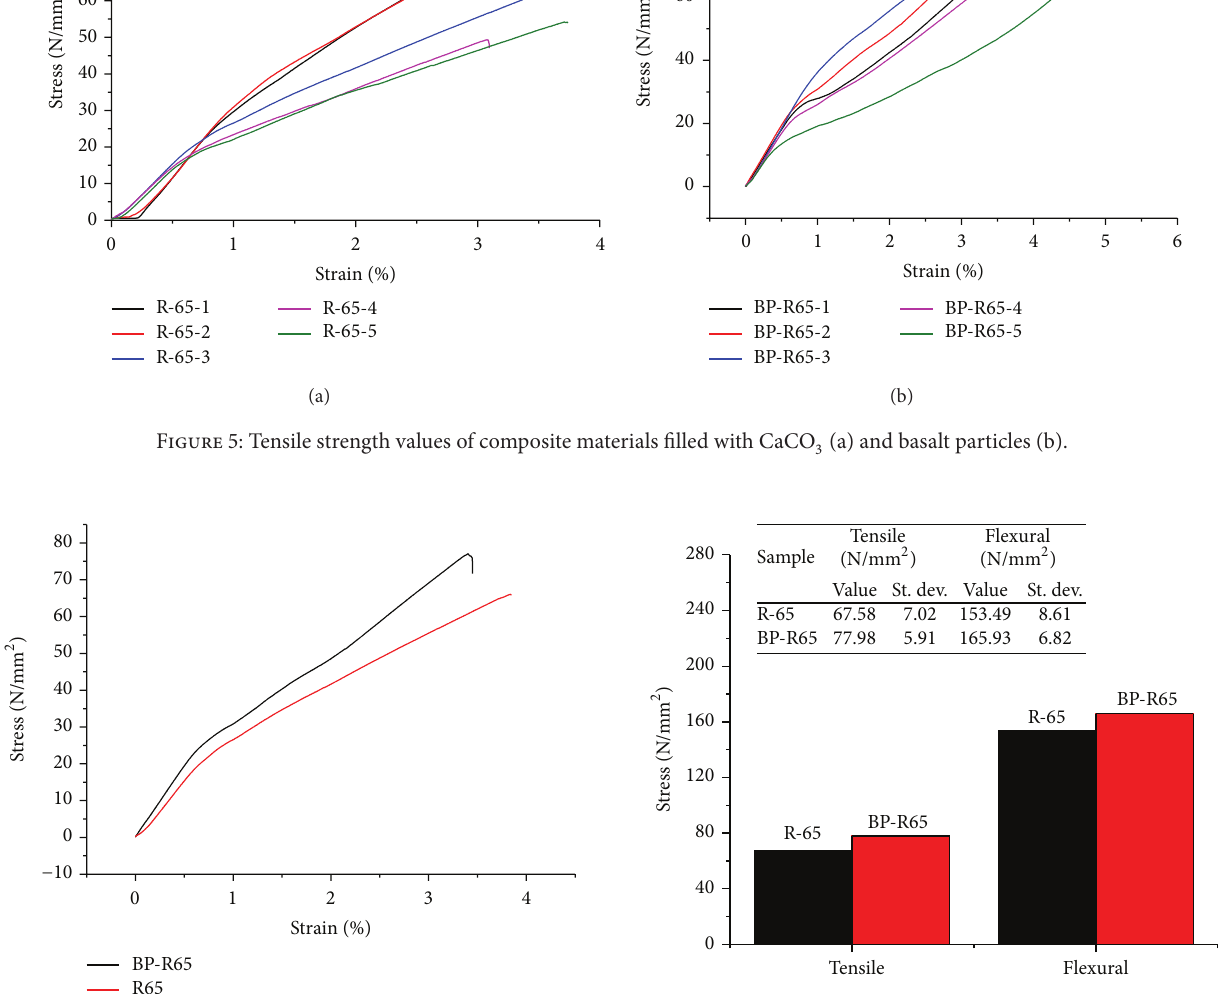
Figure 6: Sample tensile strength values of a specimen.